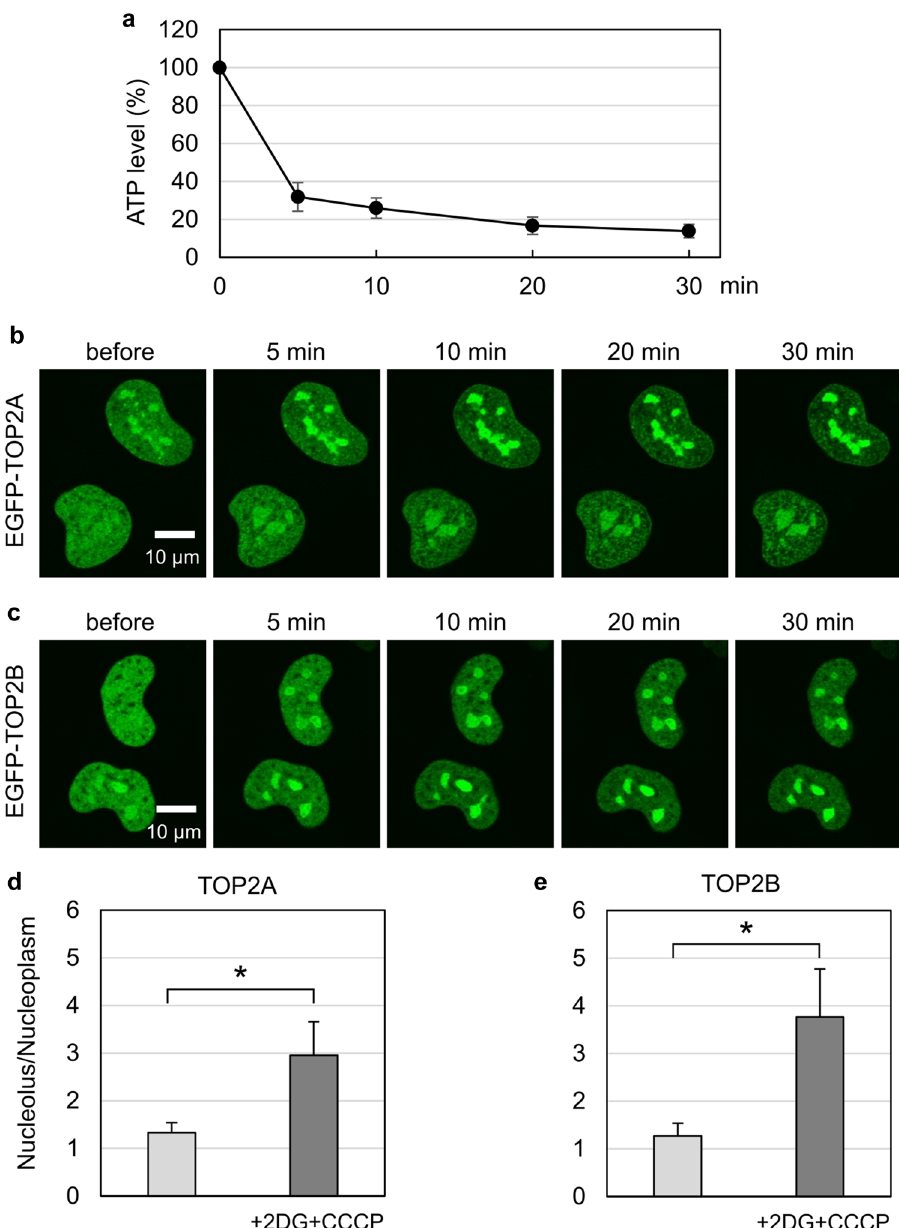
Figure 1. ATP depletion induces translocation of EGFP-TOP2A and EGFP-TOP2B to the nucleoli. ( a ) Intracellular ATP levels after 2DG/CCCP treatment. HeLa cells were treated with 25 mM 2-deoxyglucose and 10 µM CCCP, and intracellular ATP levels were measured at the indicated time points. Average values with SD from 6 independent experiments were plotted. ( b ) Translocation of EGFP-TOP2A to the nucleoli by ATP depletion. Cells expressing EGFP-TOP2A were treated with 25 mM 2DG and 10 µM CCCP, and images were captured at the indicated time points. ( c ) Translocation of EGFP-TOP2B to the nucleoli by ATP depletion. An experiment was performed on EGFP-TOP2B as described in ( b ). ( d, e ) Nucleolus-to-nucleoplasm ratios of EGFP fluorescence. Cells expressing EGFP-TOP2A ( d ) or EGFP-TOP2B ( e ) were incubated in the presence and absence of 25 mM 2DG and 10 µM CCCP, and images were captured at 20 min. Green fluorescence in the nucleolus and nucleoplasm was quantified, and average values of the nucleolus-to-nucleoplasm ratio and SD were calculated (n = 30; *: statistically significant, d : p = 7.97E−14, e : p =